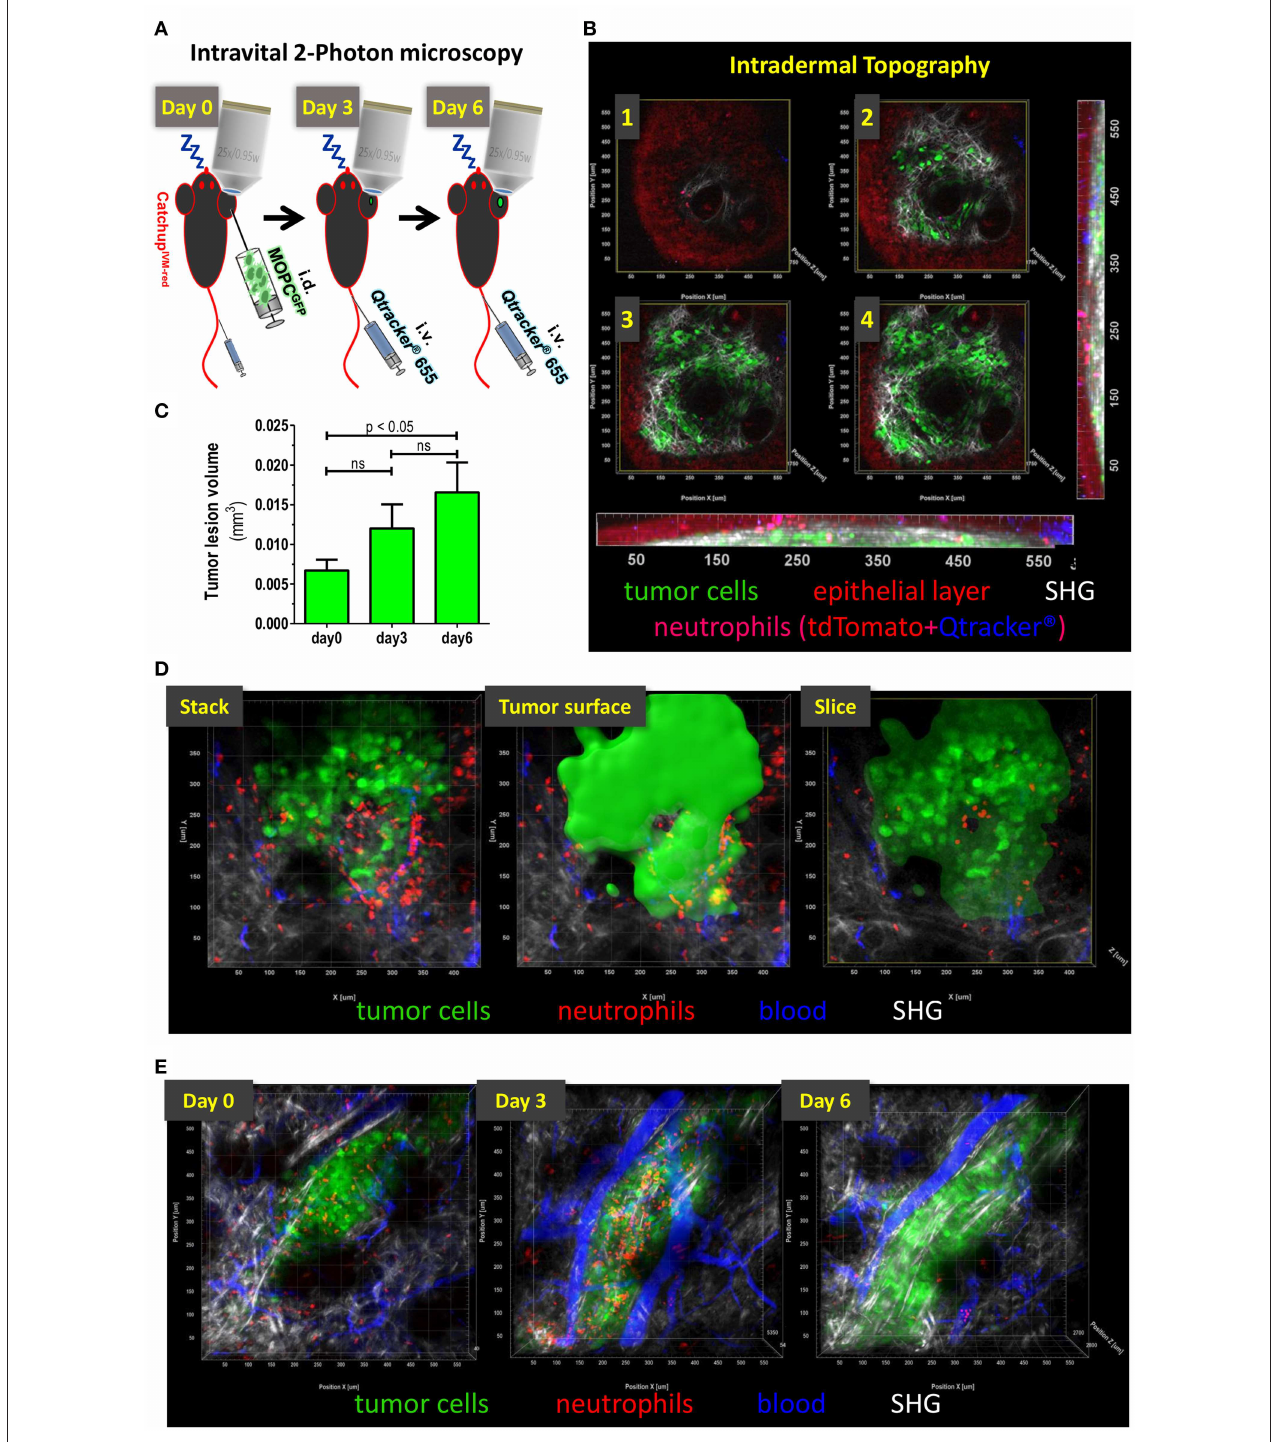
FIGURE 1 | Topography of small intradermal lesions of tumor cells. (A) Experimental scheme for longitudinal analysis of spatio-temporal dynamics of TAN. After narcosis Catchup IVM − red mice were intradermally injected with MOPC EGFP cells into the dorsal ear skin (day 0). Directly before imaging Qtracker ® vascular label 655 was injected i.v. into the tail vein or retrobulbar to visualize blood vessels. Imaging procedure on the same tumor lesion was repeated on days 3 and 6. (B) Images 1–4 show single cross sections in different depth in a multidimensional 2-Photon stack of an advanced tumor ( > day 10). Orthogonal maximum intension projection (MIP) in the x-z-plane (bottom) and y-z-plane (right). Epidermal layer shows a weak autofluorescent signal in the tdTomato emission spectrum (red). Neutrophils show highly